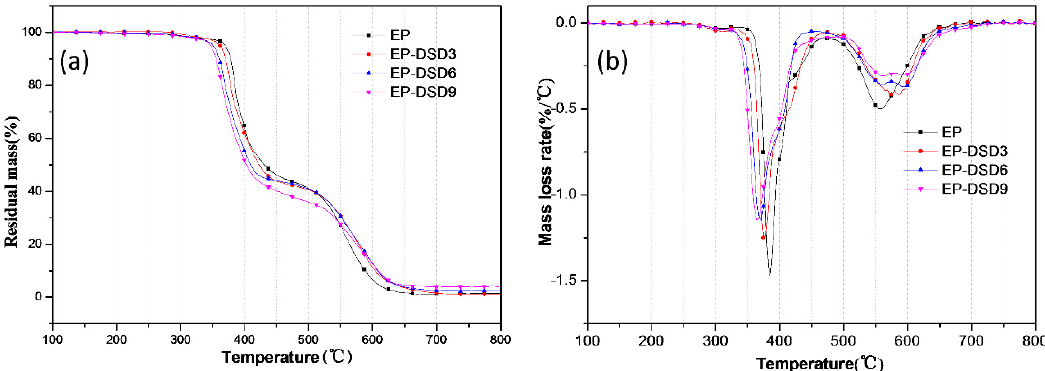
Figure 7. TG ( a ) and DTG ( b ) curves of epoxy thermosets under air atmosphere. Table 3. TGA data of epoxy thermosets under air atmosphere.